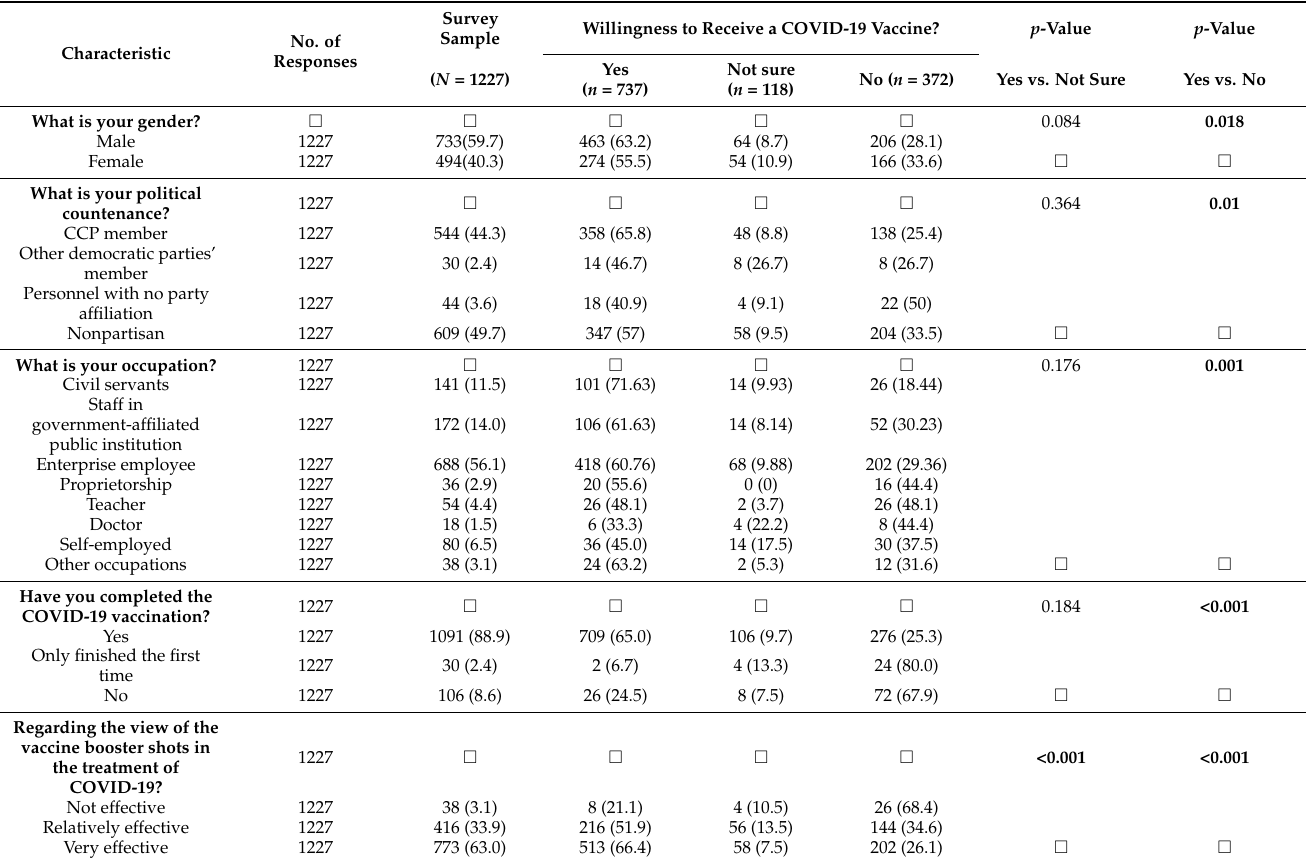
Table 4. t -test on personal characteristics (occupational characteristics) and willingness to the vaccine booster shots.